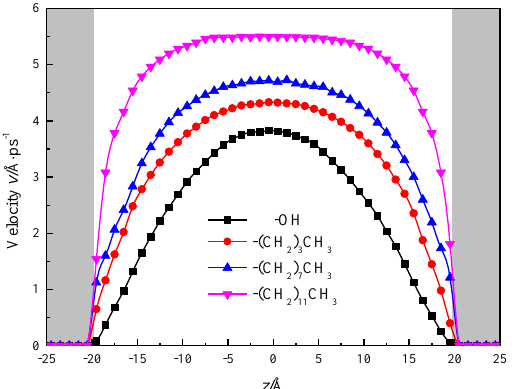
Figure 11. Velocity distribution of water in nanochannel with different surface characteristics.